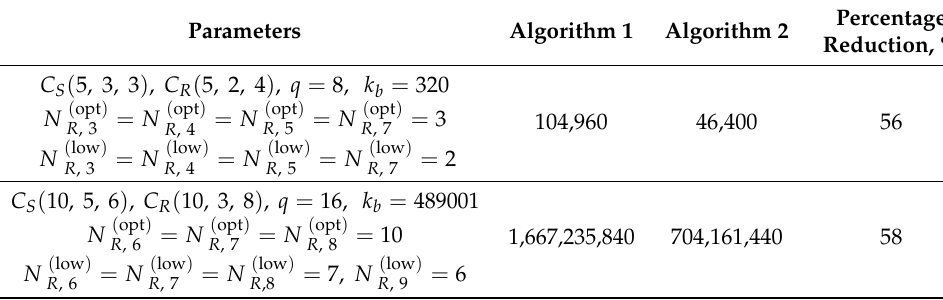
Table 7. Complexity comparison between Algorithm 1 and Algorithm